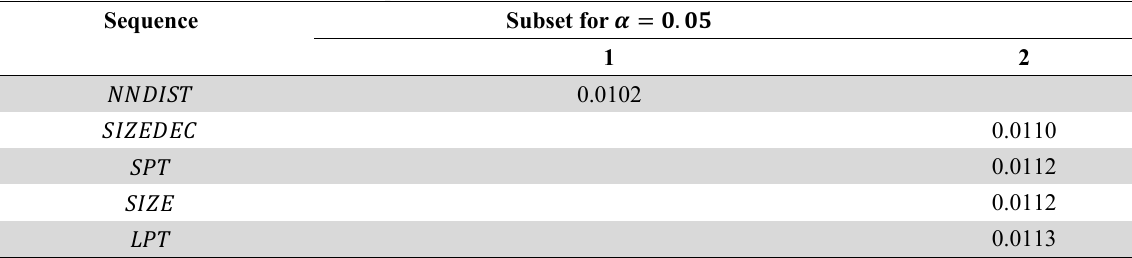
Tukey’s HSD test results for the initial sequences Sequence Subset for 𝜶 = 𝟎 . 𝟎𝟓 1 2 𝑁𝑁𝐷𝐼𝑆𝑇 0.0102 𝑆𝐼𝑍𝐸𝐷𝐸𝐶 0.0110 𝑆𝑃𝑇 0.0112 𝑆𝐼𝑍𝐸 0.0112 𝐿𝑃𝑇 0.0113